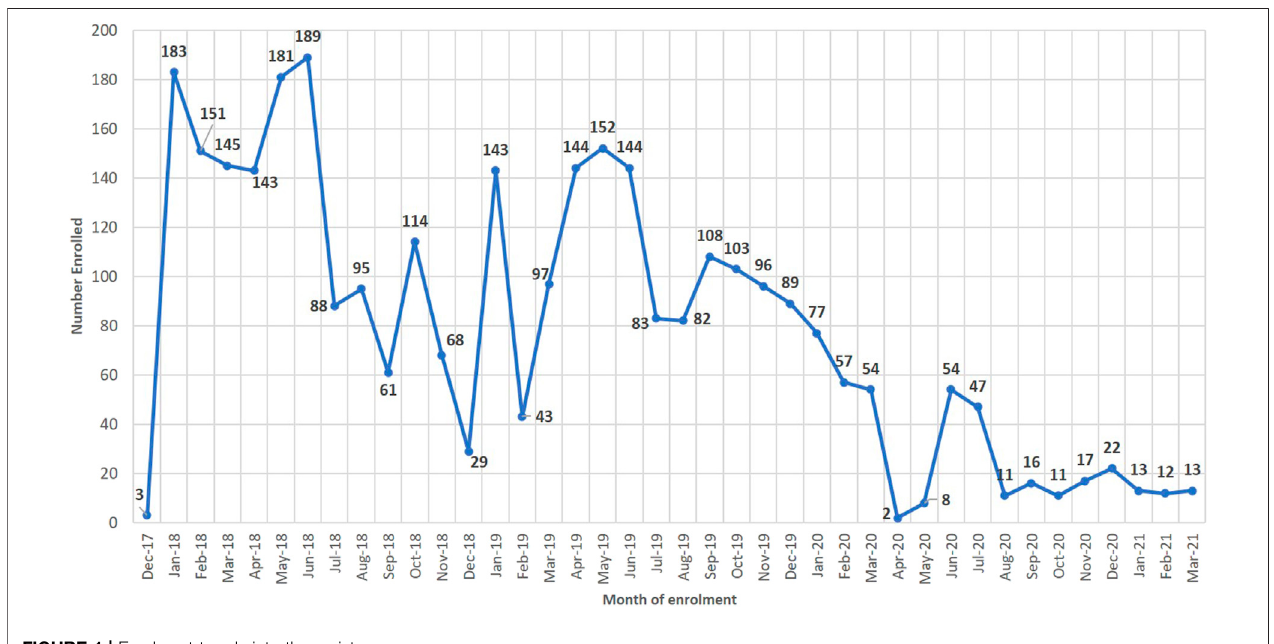
FIGURE 1 | Enrolment trends into the registry.